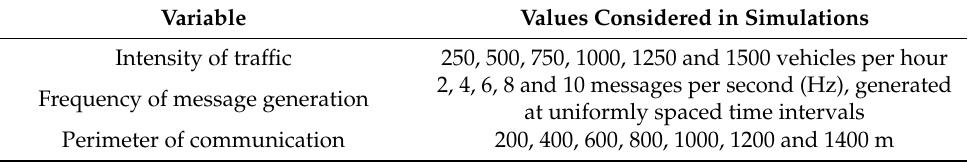
Table 2. Variables deployed in simulations.